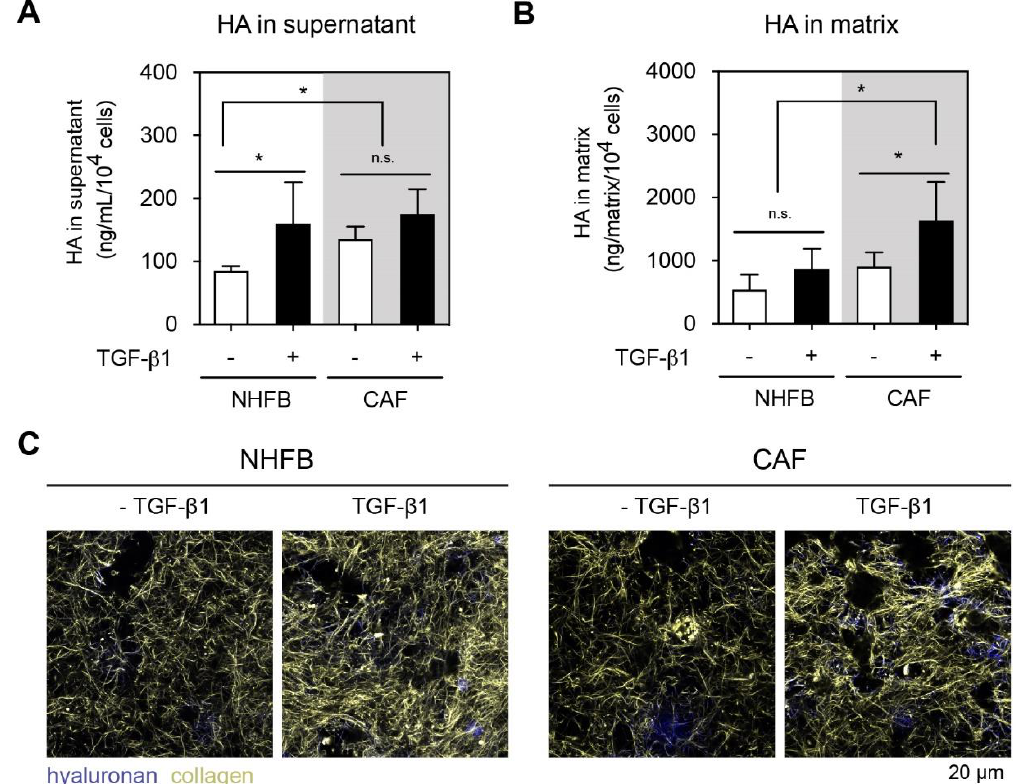
Figure 3. HA production and localization. HA amount of ( A ) cell culture supernatant and ( B ) decellularized matrices were analyzed using a commercial HA ELISA kit. Data are represented as mean ± SD; *—significance level of p < 0.05; n.s.—not significant. ( C ) Representative images of decellularized 3D collagen matrices of FB and CAF in dependency of TGF- β 1. Matrices were stained with biotin-tagged HABP followed by streptavidin conjugated with Alexa Fluor 488 to visualize HA (dark blue). Collagen fibrils were visualized using reflection mode (grey-yellow). All quantitative experiments were performed at least in 3 replicates using fibroblasts and CAF from 3 different donors for each condition.